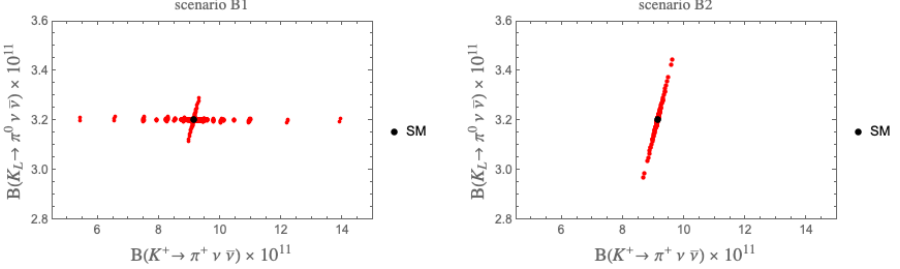
Figure 9 . Scenarios B1 (left panel) and B2 (right panel). Correlation between B ( K L ! (cid:25) 0 (cid:23) (cid:22) (cid:23) ) and B ( K + ! (cid:25) + (cid:23) (cid:22) (cid:23) ). The black dot represents the central value of the SM